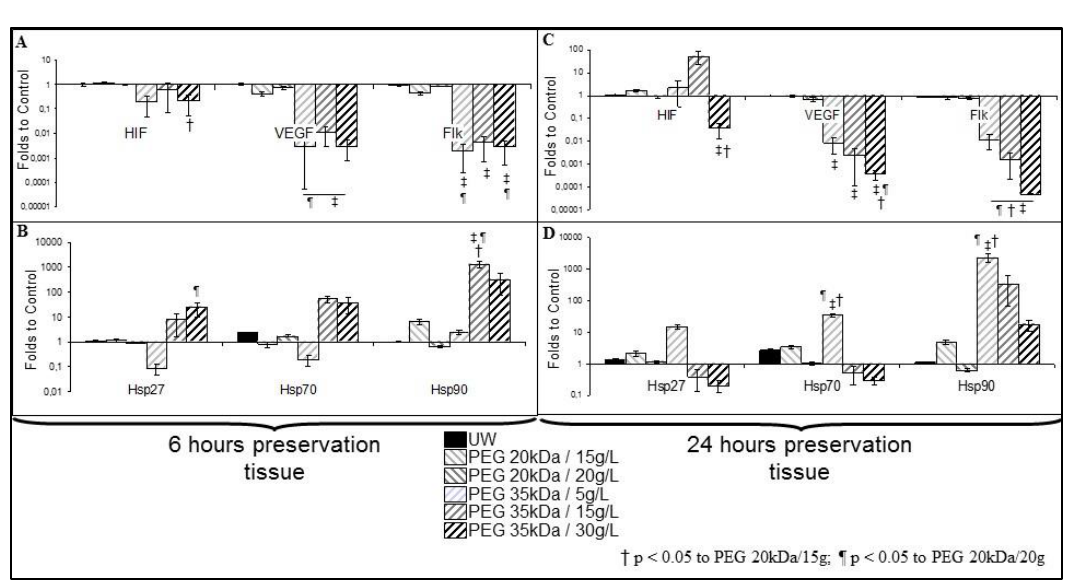
Figure 2. Reverse Transcription quantitative Polymerase Chain Reaction (RTqPCR) on preserved kidneys. Porcine kidneys underwent 6h ( A , B ) or 24h ( C , D ) preservation in UW or PEG solutions. Messenger RNA (mRNA) expression is calculated as fold over control cells, incubated in regular medium for 48 h. Shown are mean + SEM. Statistics: ‡ p < 0.05 to UW; † p < 0.05 to PEG 20 kDa/15 g; t¶ p < 0.05 o PEG 20 kDa/20 g. n = 3.